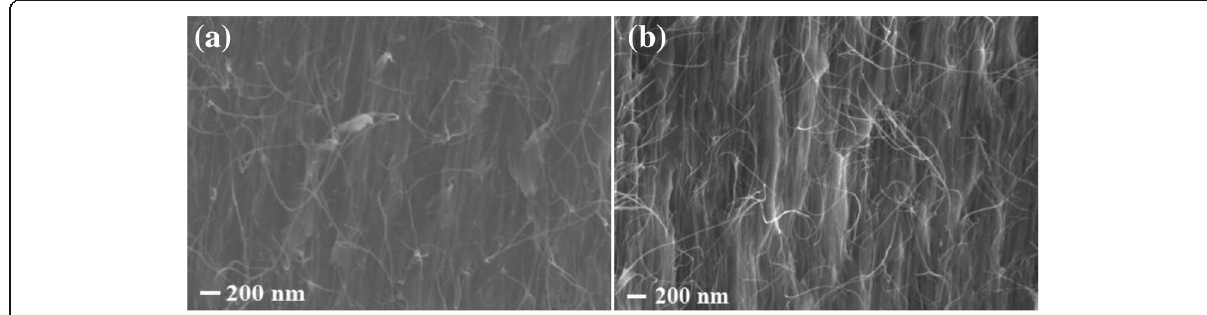
Fig. 8 Cross-sectional SEM images of composite films with VACNTs grown on different buffer layers: a ALD Al 2 O 3 and ( b ) EB Al 2 O 3